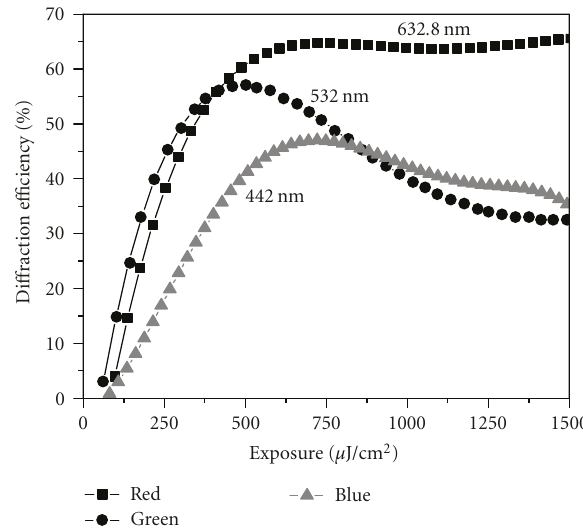
Figure 2: Exposure characteristics of HP-P for reflection RGB holographic